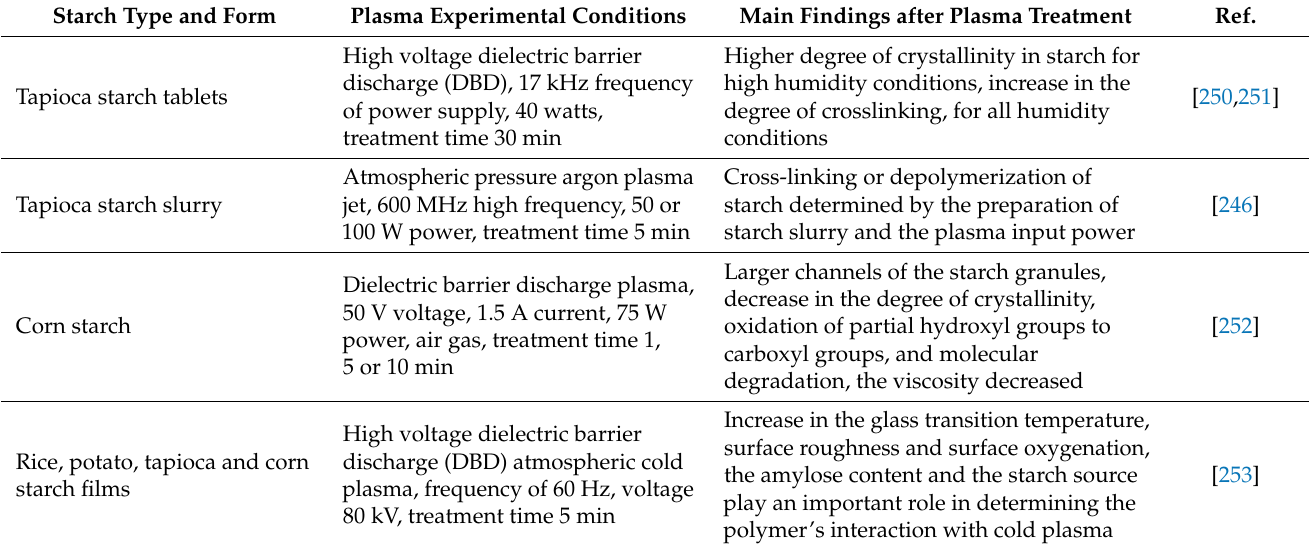
Table 2. The effect of atmospheric pressure cold plasma upon